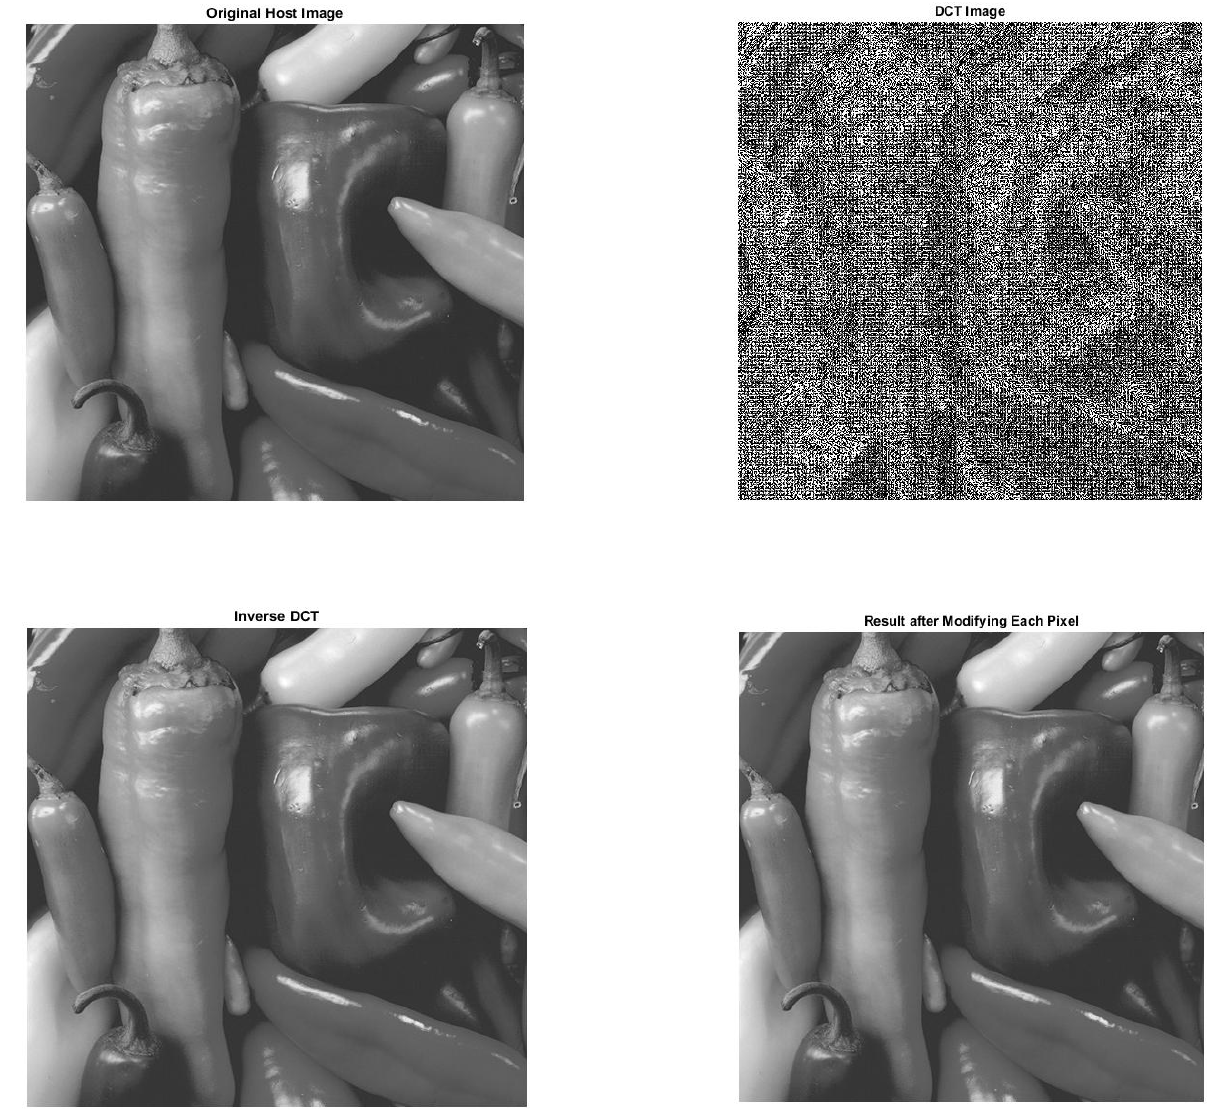
Figure 8. Modification based on DCT.